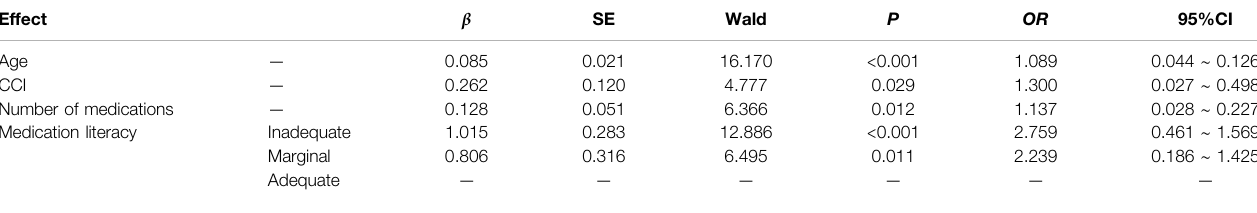
TABLE 5 | | Results of logistic regression analysis of frailty determinants for inpatients with CHD ( N (cid:1) 280). Effect